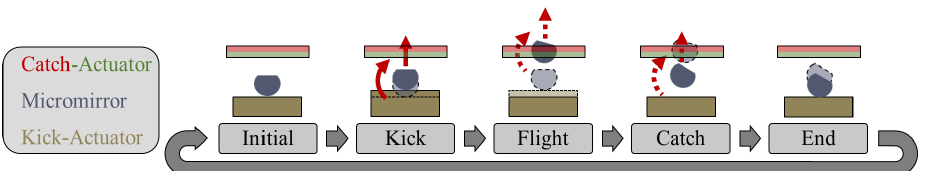
Figure 1. Working principle of the kick and catch actuator system: the kick-actuator launches the hemispherical micromirror into a flight phase. Subsequently, the electromagnetic catch-actuator controls the mirror’s flight. Finally, the catch-actuator decelerates the sphere and supports its smooth landing on the kick-actuator. This sequence achieves a small rotation of the hemisphere and may be repeated periodically to achieve large deflections. Please note the symbolic nature of this illustration. Later versions of the catch-actuator may, for example, contain a three-dimensional Helmholtz-coil configuration. Furthermore, this work focuses on further developing and applying the mathematical methodology of model order reduction (MOR). For this reason, the system is simplified to vertical